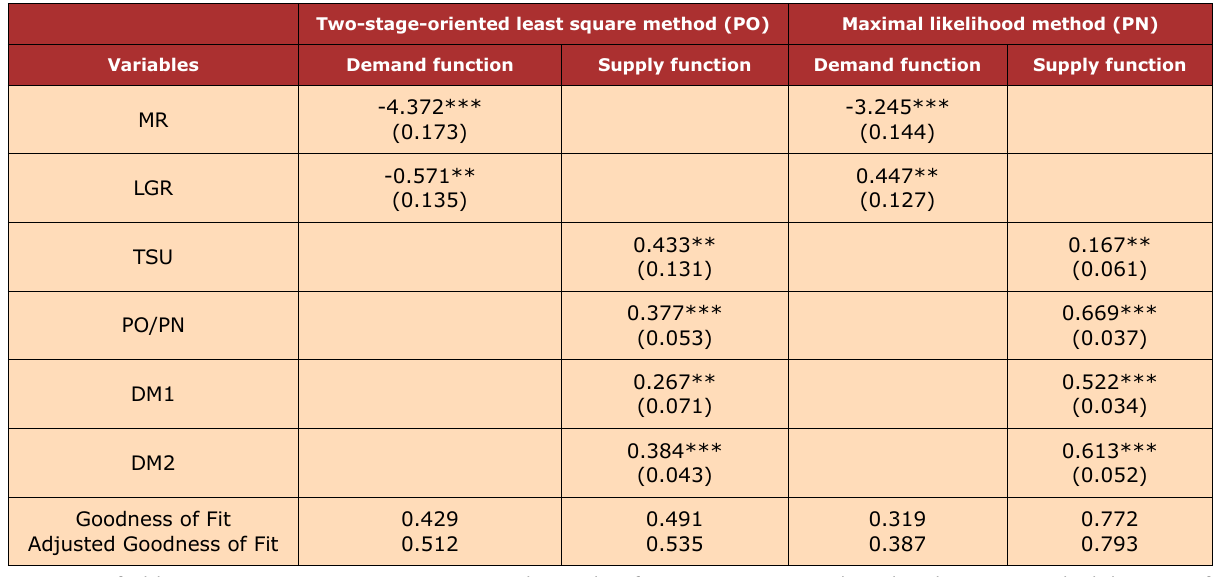
Table 3. Collusion estimation